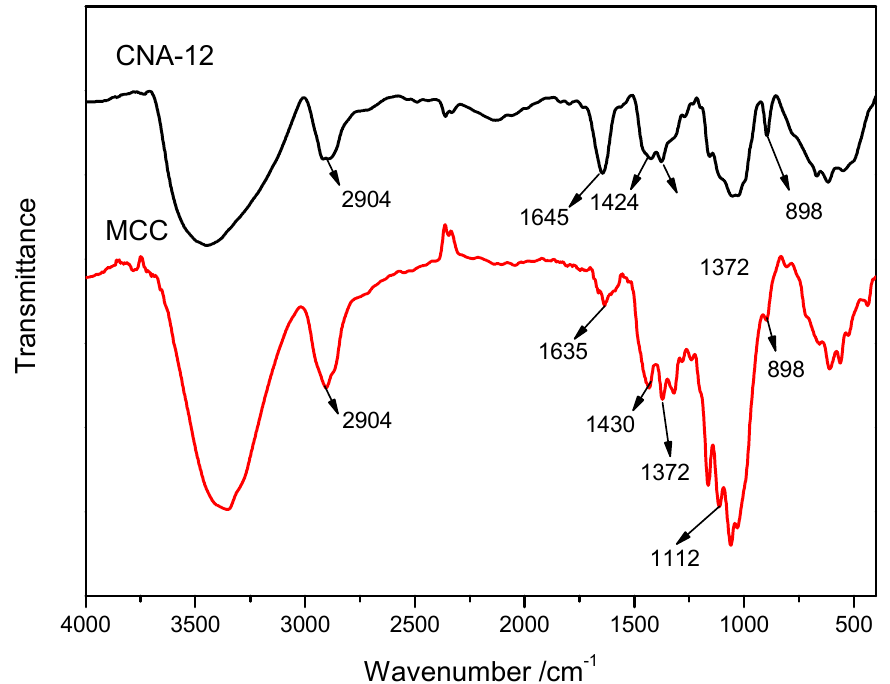
Figure 3. Fourier-transform infrared spectroscopy spectra of original cellulose and CNA-12 samples.